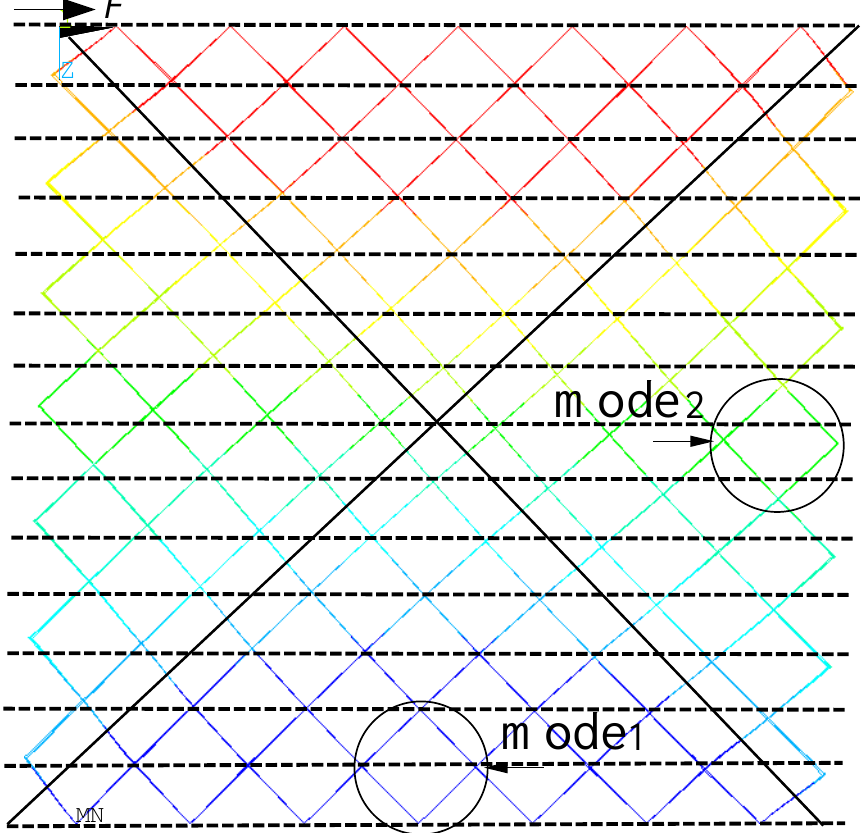
Figure 3. Deformation pattern of multi-layer BCC lattice structures.